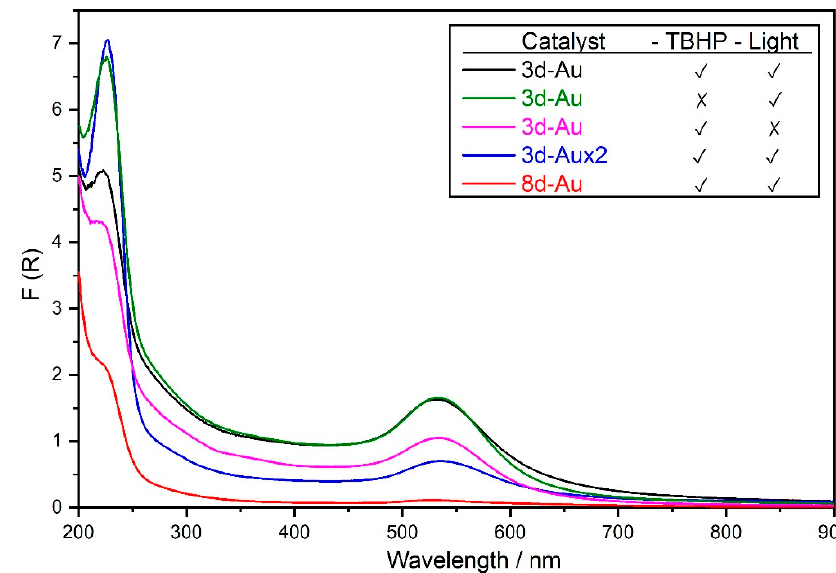
Figure 7. UV-vis spectra of the used catalysts.